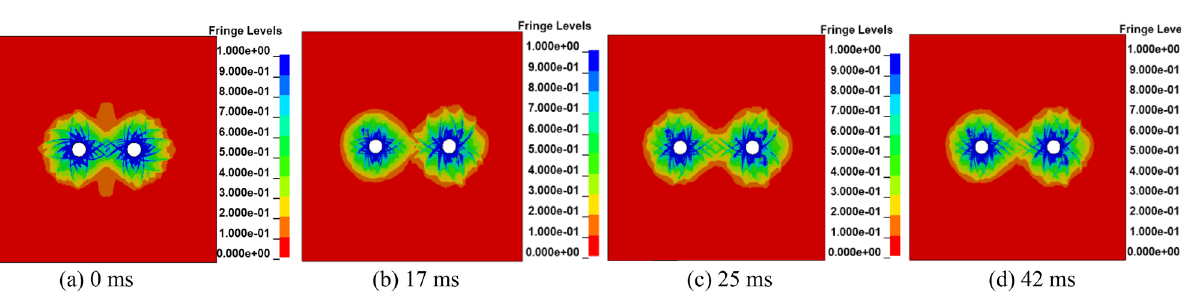
Figure 3. Damage distribution cloud map of different hole spacings.